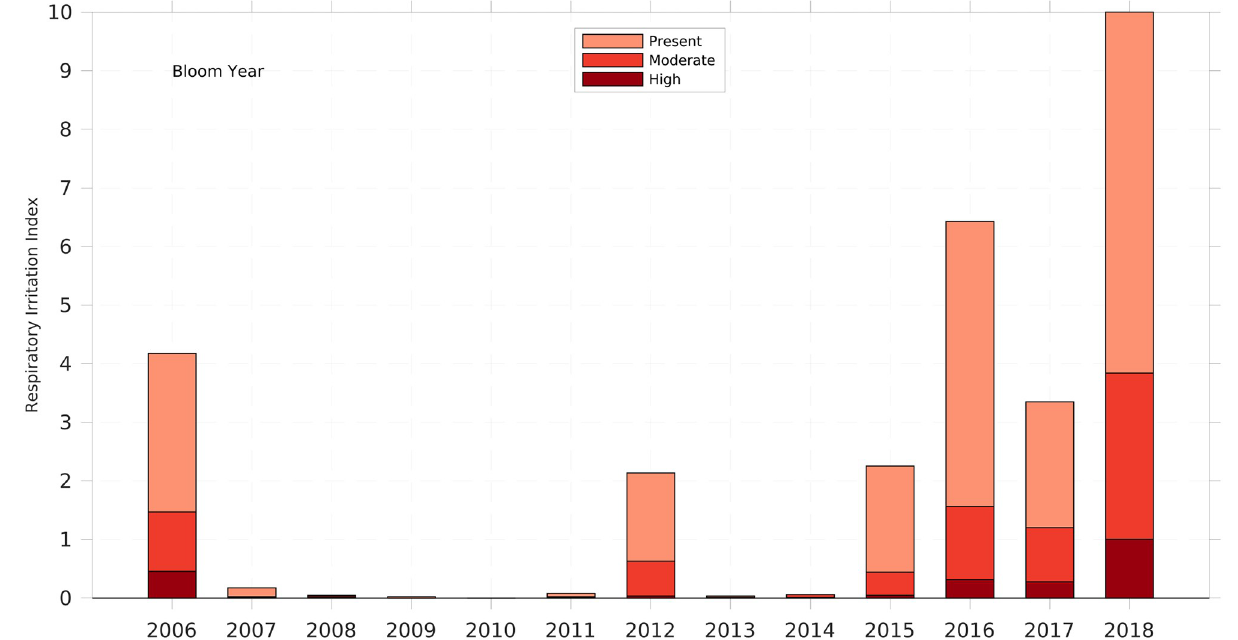
Fig 7. Respiratory irritation index for each bloom year for Manatee and Sarasota Counties, 2006 to 2018. The bloom year starts in August and ends the following July, e.g., 2006 includes August 2006 to July 2007. The respiratory irritation index was defined by the total beach days over the year of each irritation condition (present, moderate, and high), and scaled such that the year with the maximal frequency had a value of 10, and zero indicates no respiratory irritation at any beach during the year.